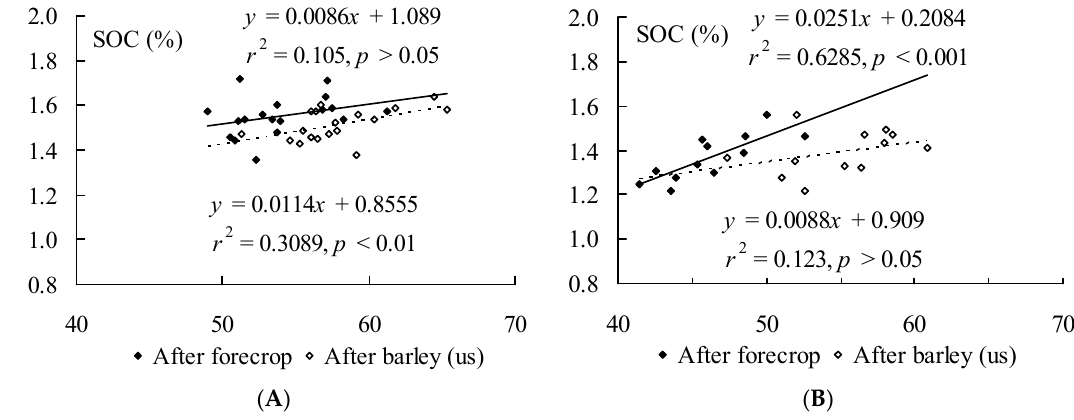
Figure 1. The relationships between soil hydrolytic activity ( µ g of fluorescein g − 1 soil dry mass h − 1 ) and organic carbon (SOC, %) content in organic ( A ) and conventional ( B ) farming system after forecrop and after barley (us) cultivation.